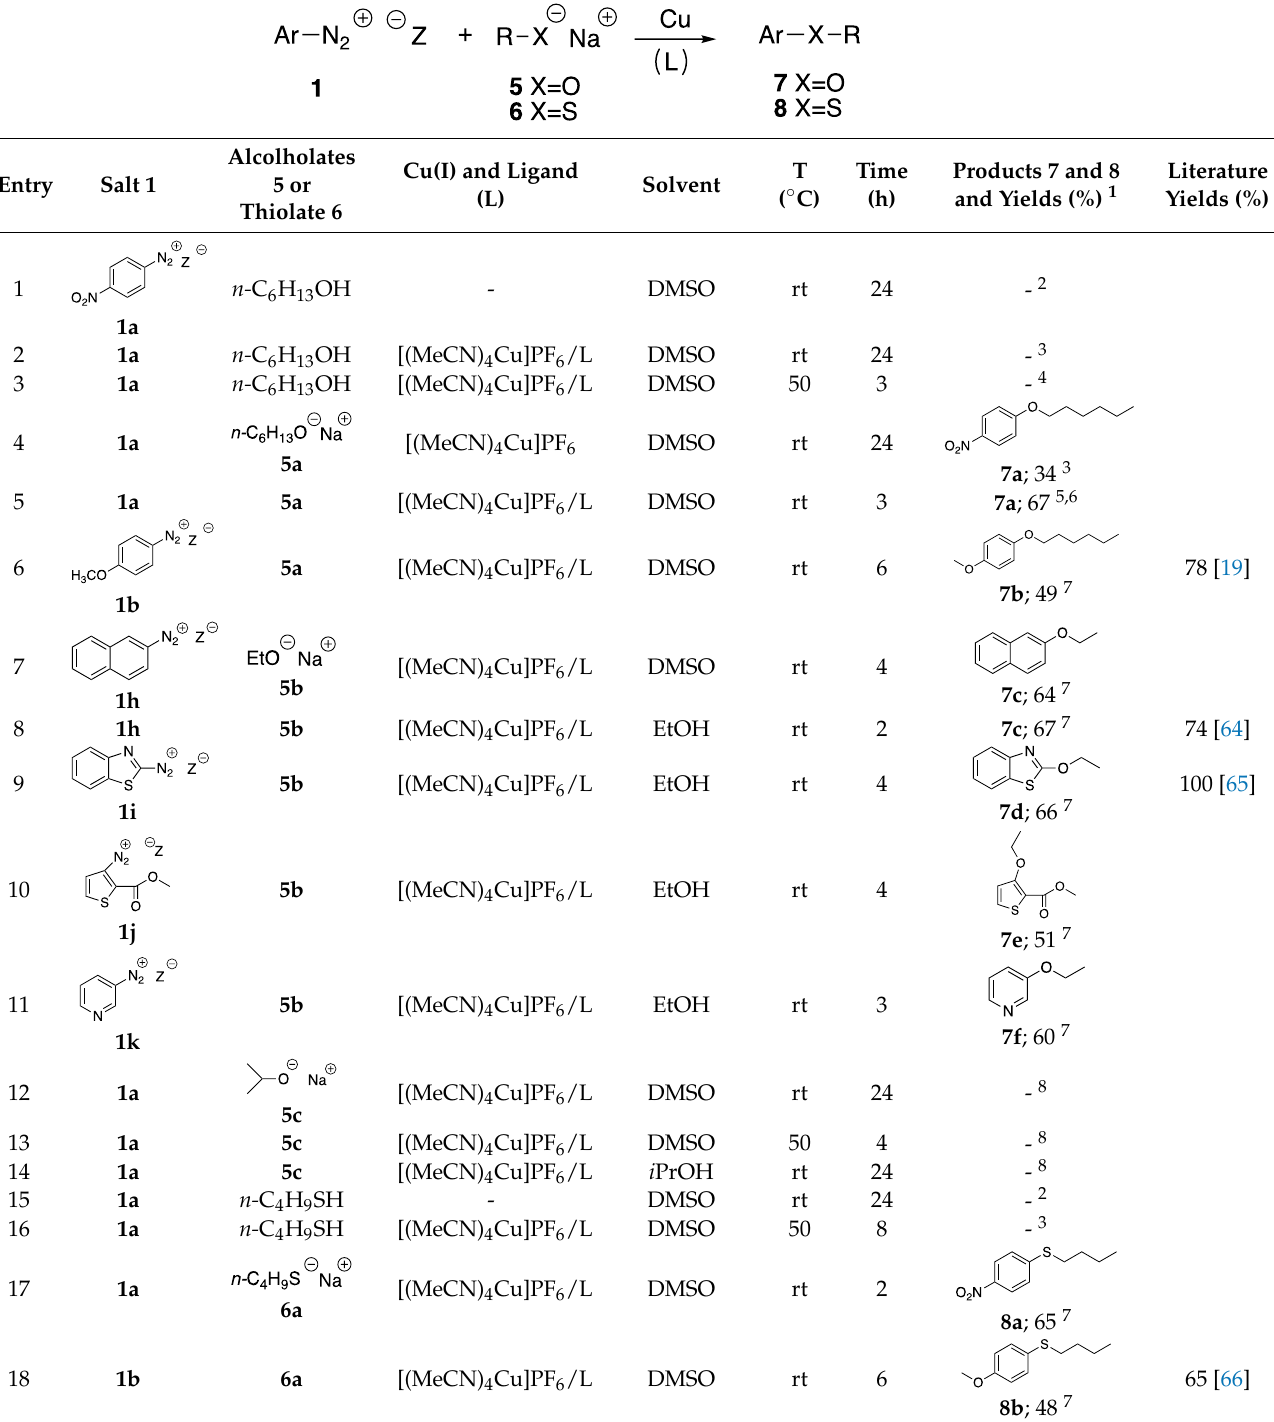
Table 2. Ullmann-type coupling between arenediazonium o -benzenedisulfonimides 1 and alcoholates 5 and thiolate 6.